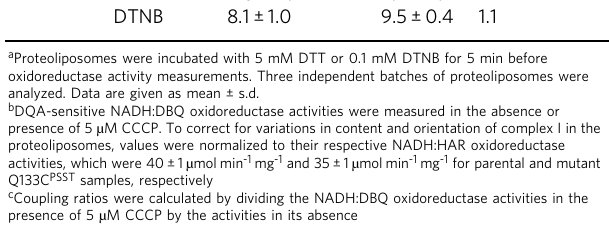
puri fi ed complex I (Supplementary Fig. 5). Treatment with DTT and DTNB had some minor effects on the intensity and shape of the EPR signatures, but these were the same with parental and mutant enzyme. Taken together, functional analysis demon- strated that mutation Q133C PSST had no detectable effect on redox centers and the electron transfer activities within the per- ipheral arm of complex I indicating that the structure of the domains executing these functions were essentially unchanged.